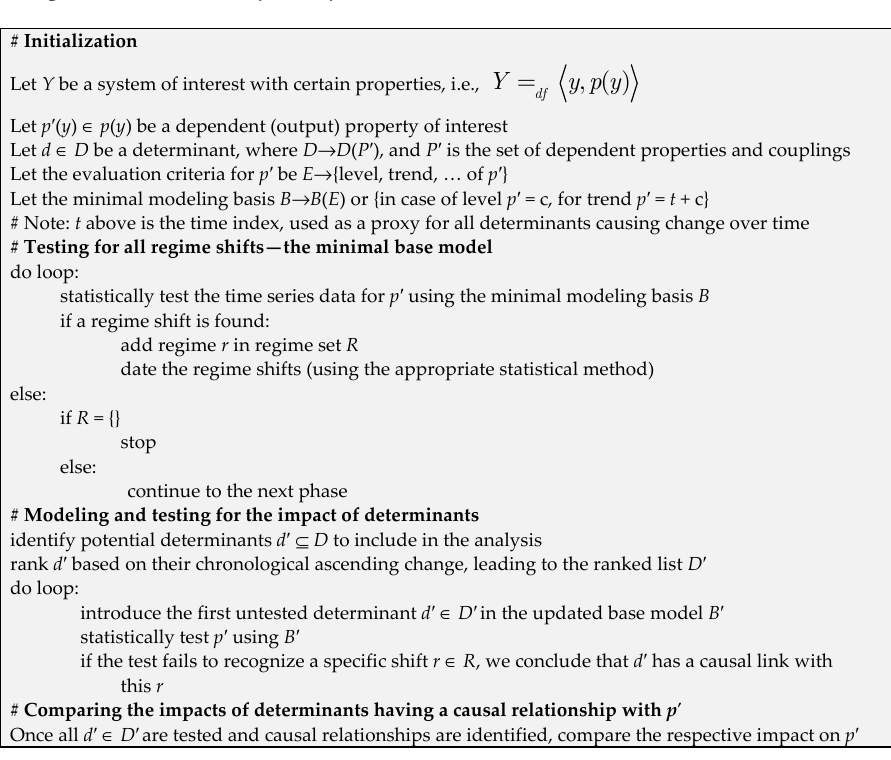
Figure 3. Procedure to find regime shifts and related determinants.